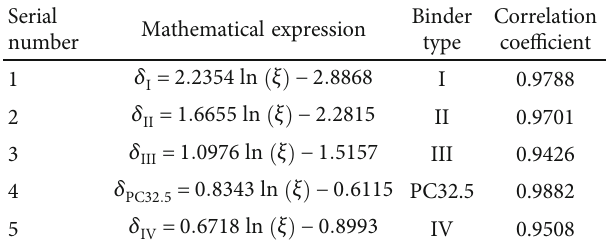
Table 6: Functional relationship of UCS and curing age (1 :4).